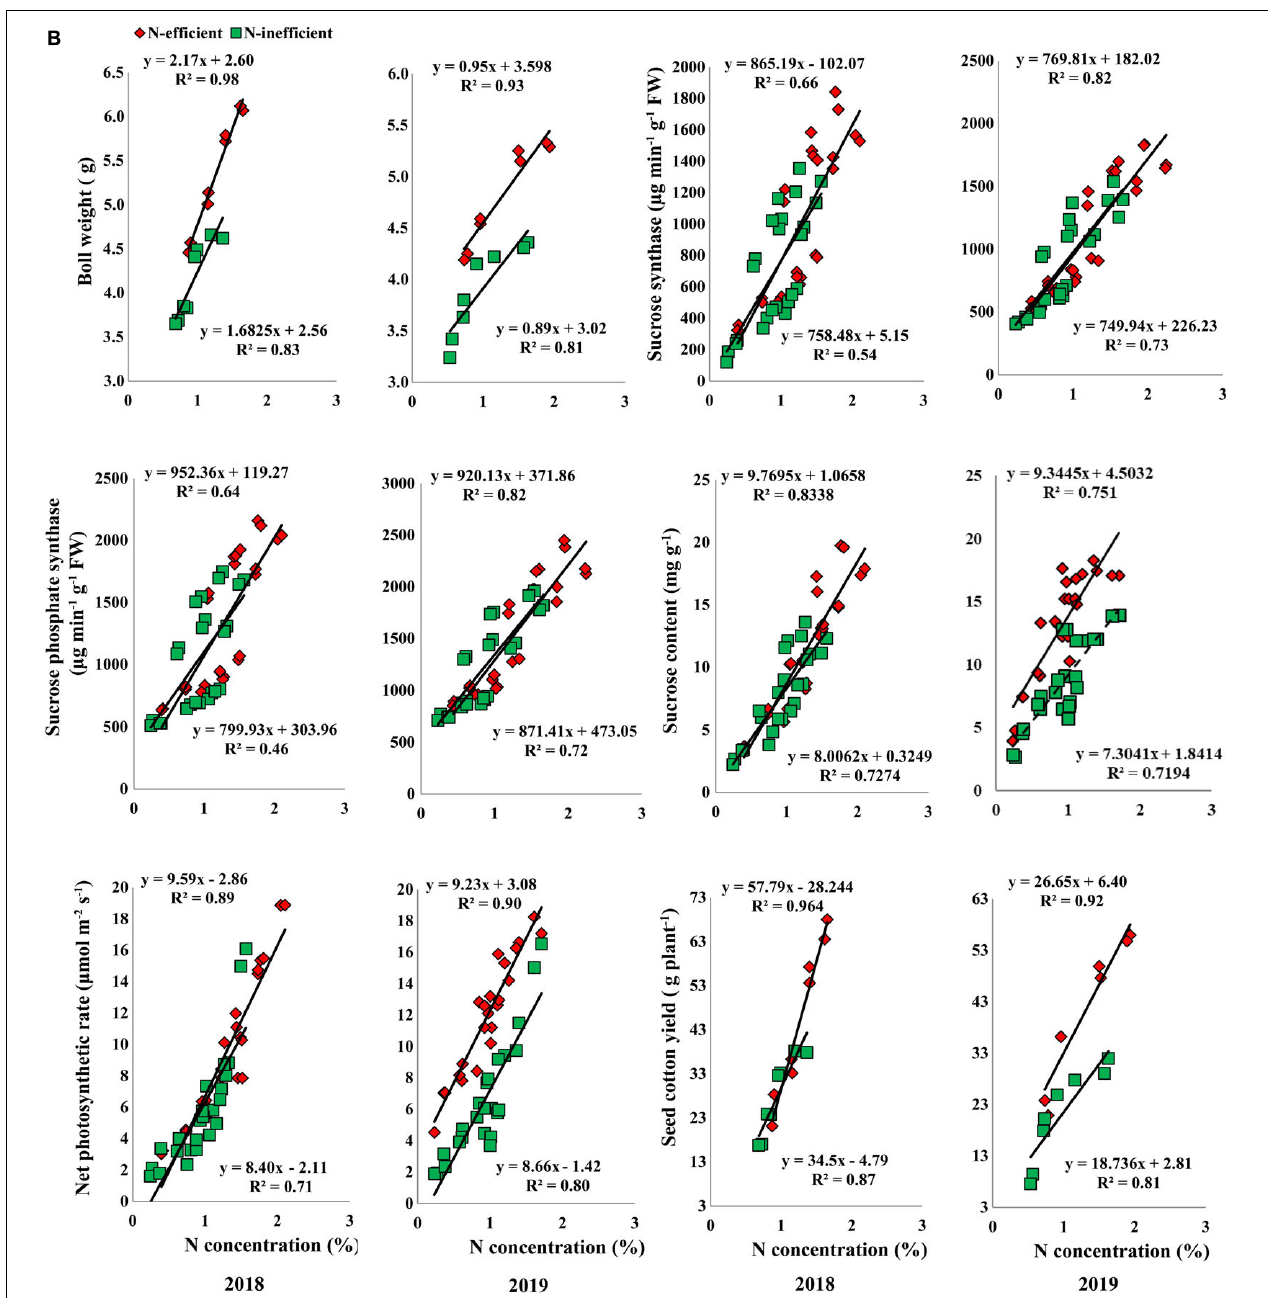
FIGURE 8 | (A) Relationships of subtending leaf N concentration (%) with nitrate reductase ( µ g g − 1 FW h − 1 ), glutamine synthetase activity ( µ mol g − 1 FW h − 1 ), glutamate synthase (U mg − 1 protein), and glutamate dehydrogenase activity (U mg − 1 protein), glutamate–pyruvic transaminase activity (nmol min − 1 mL − 1 ), glutamate oxaloacetic transaminase activity (nmol min − 1 mL − 1 ) of N-efficient (CCRI-69) and N-inefficient (XLZ-30) cotton genotypes under pot condition in 2018 and 2019. (B) Relationships of subtending leaf N concentration (%) with boll weight (g), sucrose synthase ( µ g min − 1 g − 1 FW), sucrose phosphate synthase ( µ g min − 1 g − 1 FW), sucrose content (mg g − 1 FW), net photosynthetic rate ( µ mol m − 2 s − 1 ), and seed cotton yield (g plant − 1 ) of N-efficient (CCRI-69) and N-inefficient (XLZ-30) cotton genotypes under pot condition in 2018 and